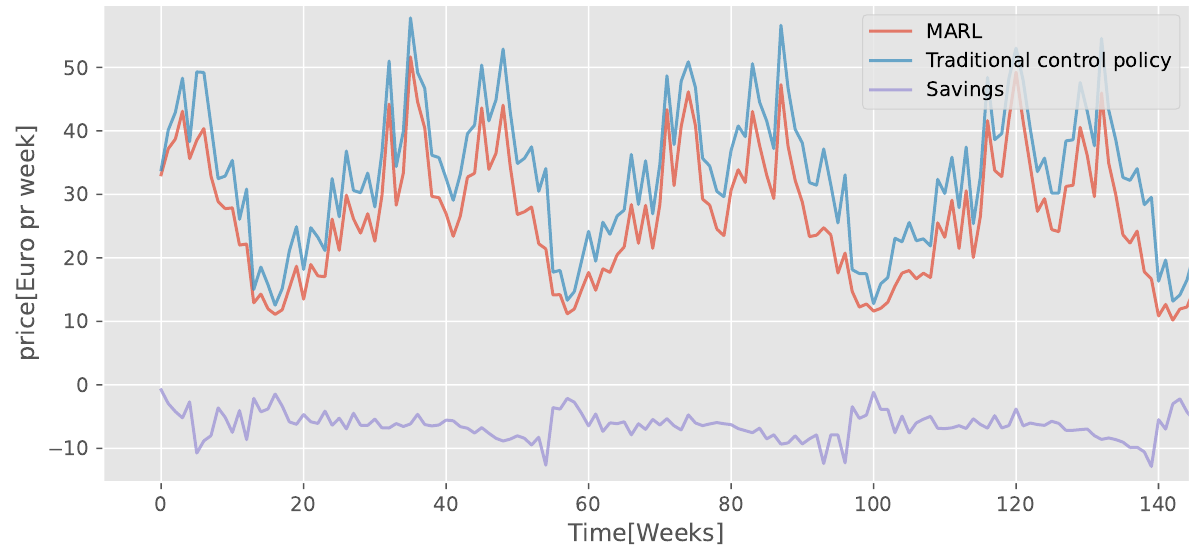
Figure 12. Price of heating per week for MARL and traditional control for a four-zone UFH system over a 1000-day